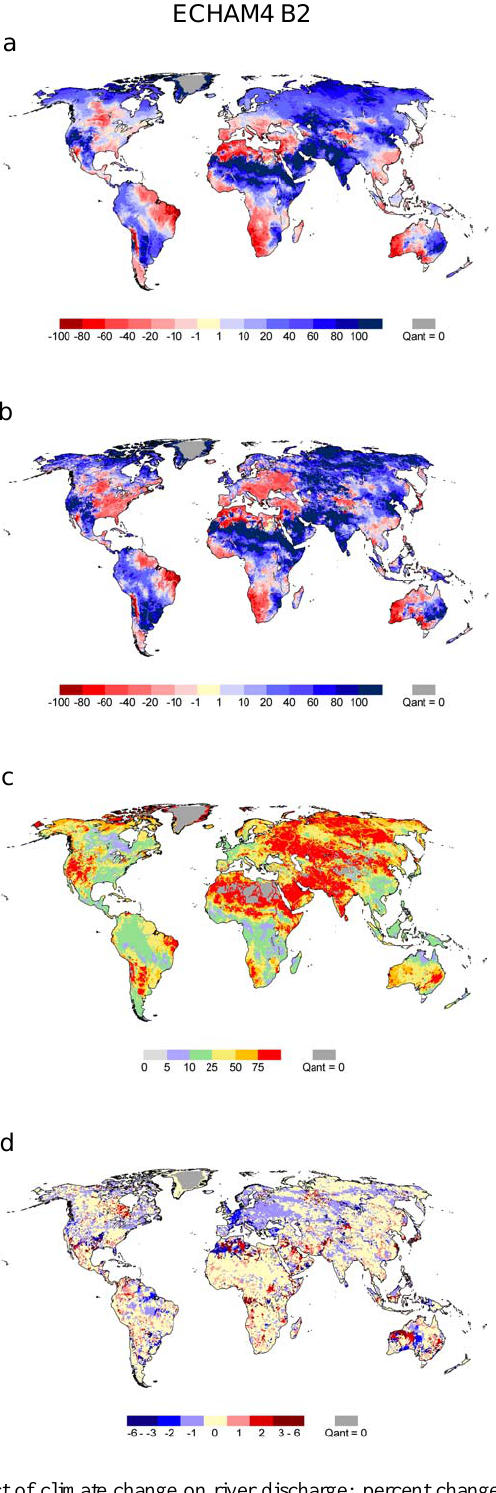
Hydrol. Earth Syst. Sci., 14, 783–799, 2010